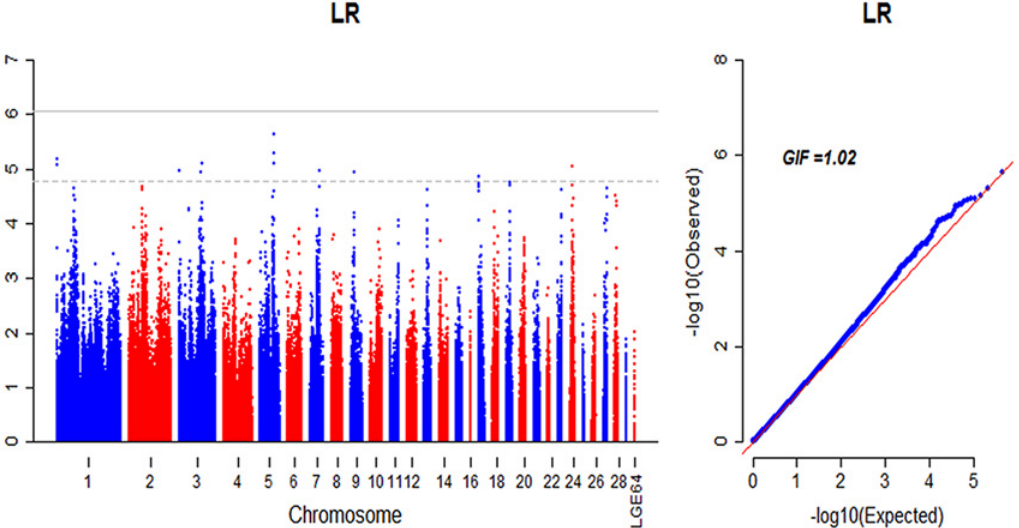
Fig 6. Manhattan and Q-Q plot of genome wide association study for egg laying rate. Each dot represents a SNP in the dataset. Manhattan plot (left). LR, egg laying rate between 25 and 40 weeks of age. The horizontal gray line and gray dashed line indicate the genome-wise significance threshold (P- value = 8.43e-7) and genome-wise suggestive significance threshold (P-value = 1.69e-5), respectively. GIF represents genomic inflation factor.